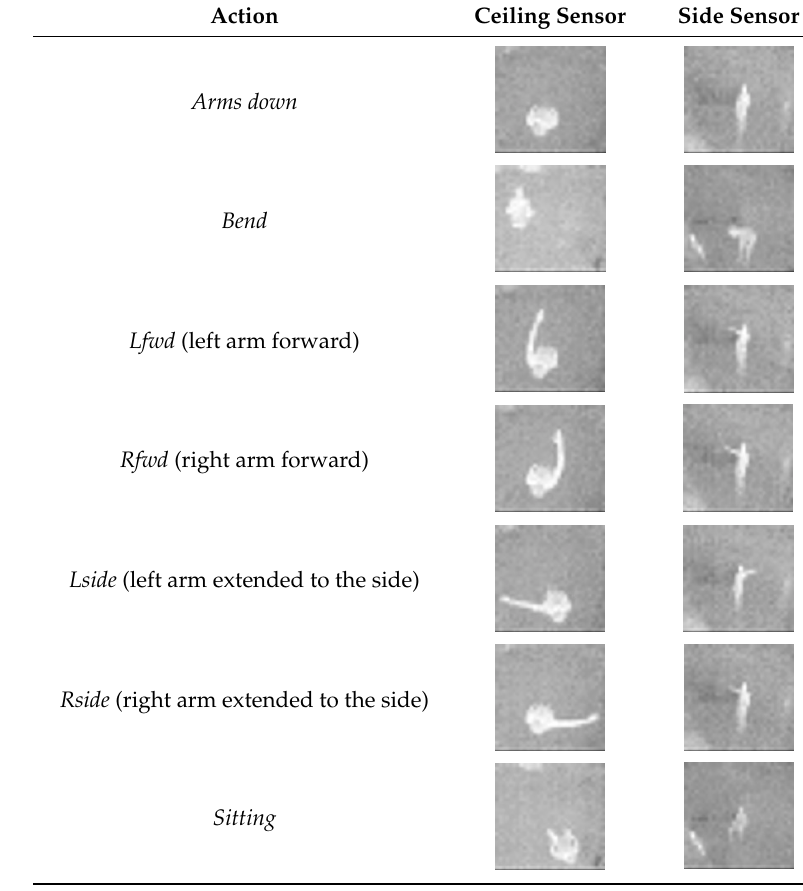
Table 2. Thermal frame examples from the ceiling and side sensors .